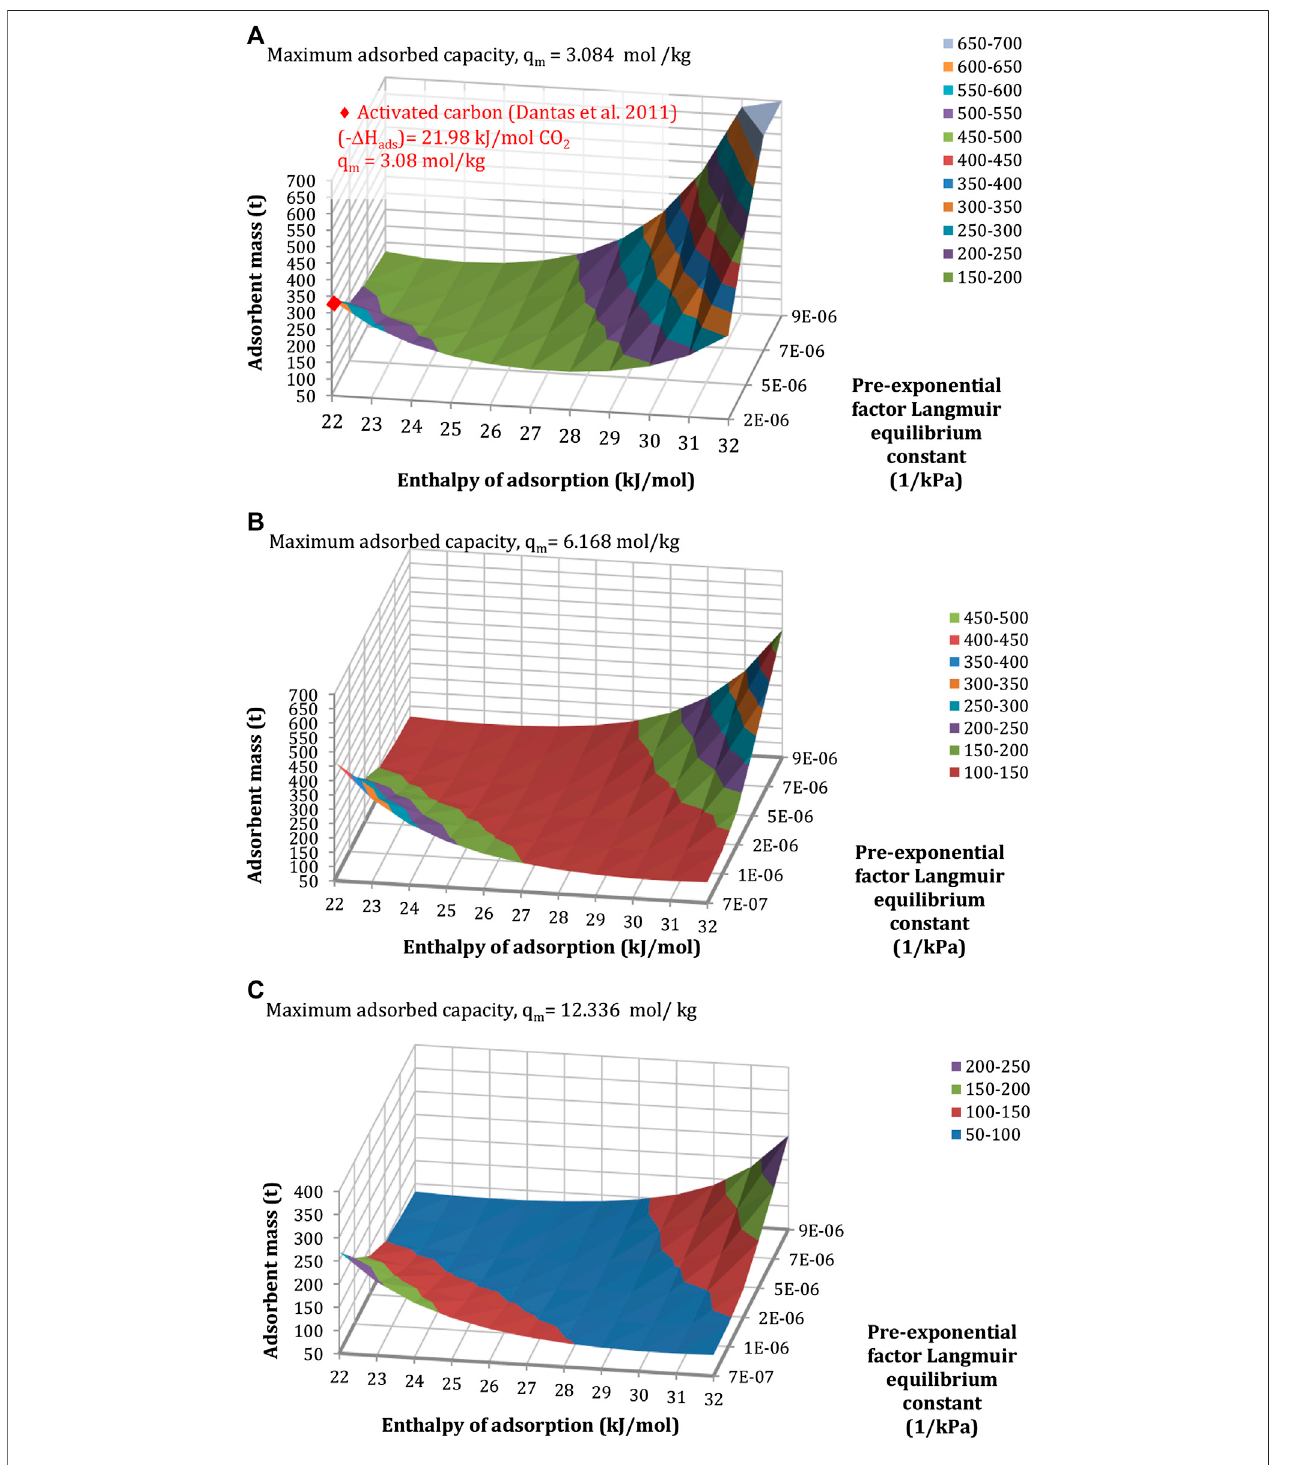
FIGURE 11 | Sensitivity of the mass of the adsorbent to the enthalpy of adsorption and the pre-exponential factor of the equilibrium constant, for a maximum adsorbed capacity of (A) 3.08 mol/kg, (B) 6.17 mol/kg, and (C) 12.34 mol/kg. Con fi guration: S-EGR in parallel at 70% recirculation ratio, 97% selective CO 2 transfer ef fi